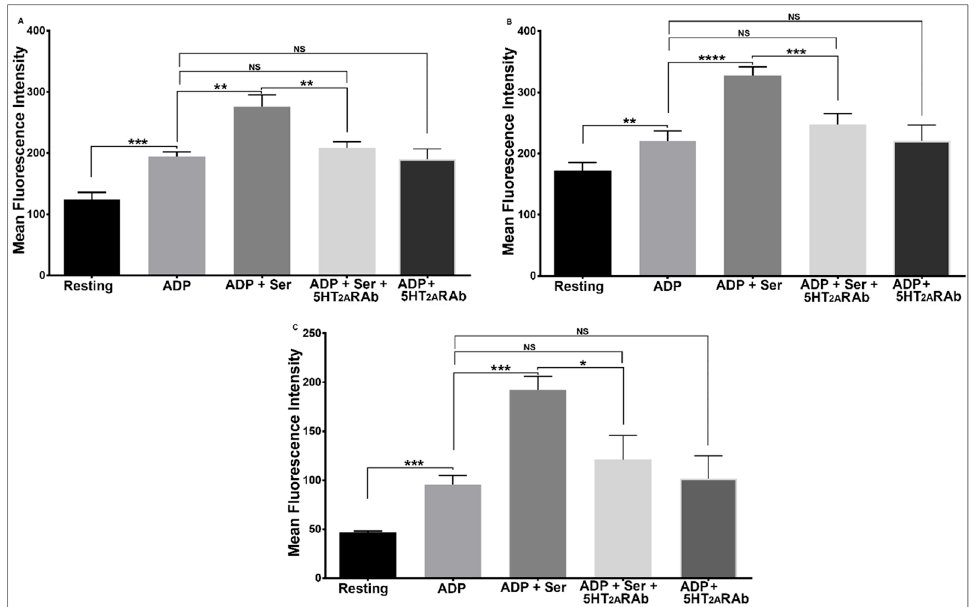
Figure 5. The 5HT 2A RAb inhibits serotonin-enhanced ADP-induced α granule secretion, GPIIb-IIIa activation, and PS exposure in human platelets in vitro. Washed human platelets were incubated in the presence or absence of the 5HT 2A RAb (150 nM) for 5 min and then stimulated with ADP (1 μ M), in the presence and absence of serotonin (15 μ M), for 3 min. The reactions were stopped by fixing the platelets with 2% formaldehyde for 30 min at room temperature. ( A ) Platelets were incubated with FITC-conjugated anti-P-selectin antibody, ( B ) FITC-conjugated PAC-1 antibody, or ( C ) FITC- conjugated Annexin V antibody, and the fluorescence intensity was measured by flow cytometry (* p < 0.05; ** p < 0.01; *** p < 0.001; **** p < 0.0001; NS, nonsignificant). Each experiment was